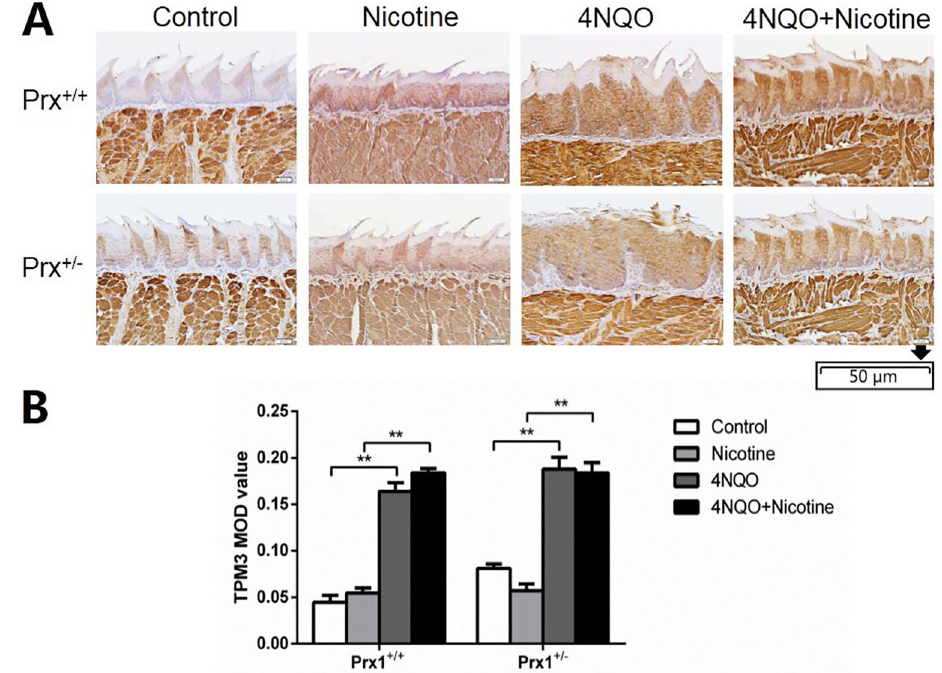
Figure 3. Immunohistochemical analysis of TPM3 in the tongue oral leukoplakia tissues of Prx1 + / + and Prx1 + / – mice. A , Representative images of TPM3 ( (cid:3) 200, scale bar 50 m m). B , The integral optical density (IOD)/measurement area (MOD) values are reported as means ± SE. **P o 0.01 (ANOVA). 4NQO: 4-nitro-quinoline-1-oxide.